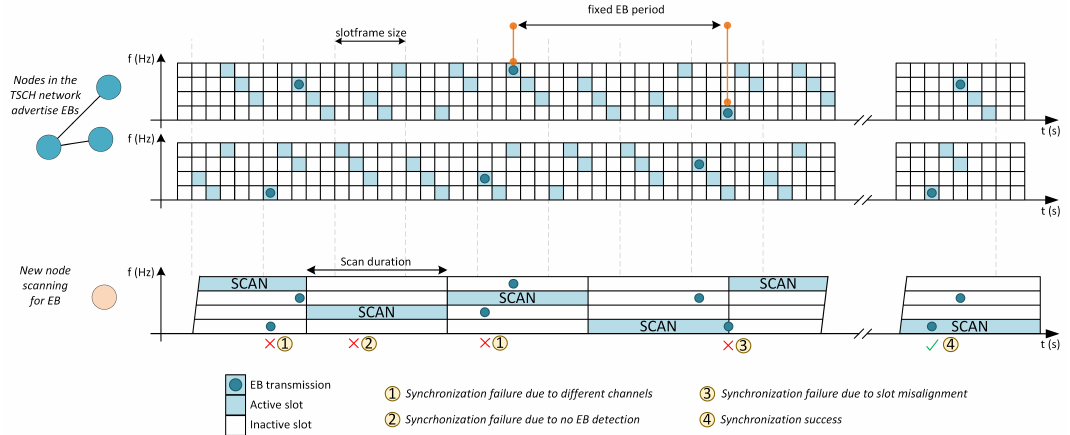
Figure 1. Example of beacon advertising process using four